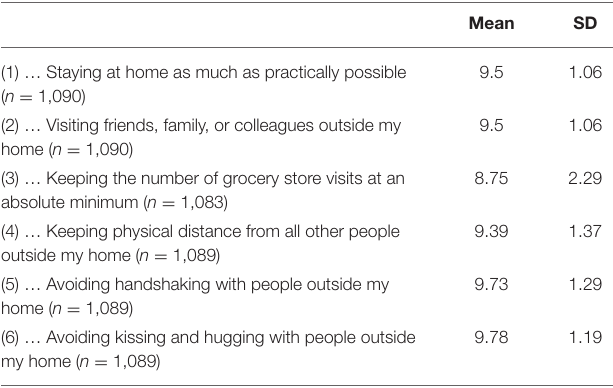
TABLE 1 | Physical contact: be as precise as you can, during the pandemic (COVID-19).